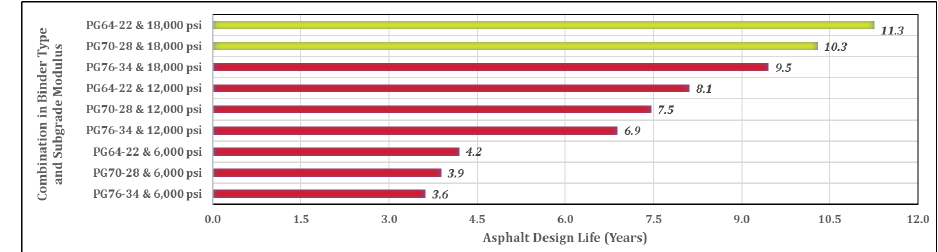
Figure 36: Influence of subgrade modulus and binder type on asphalt service life in asphaltic overlayment